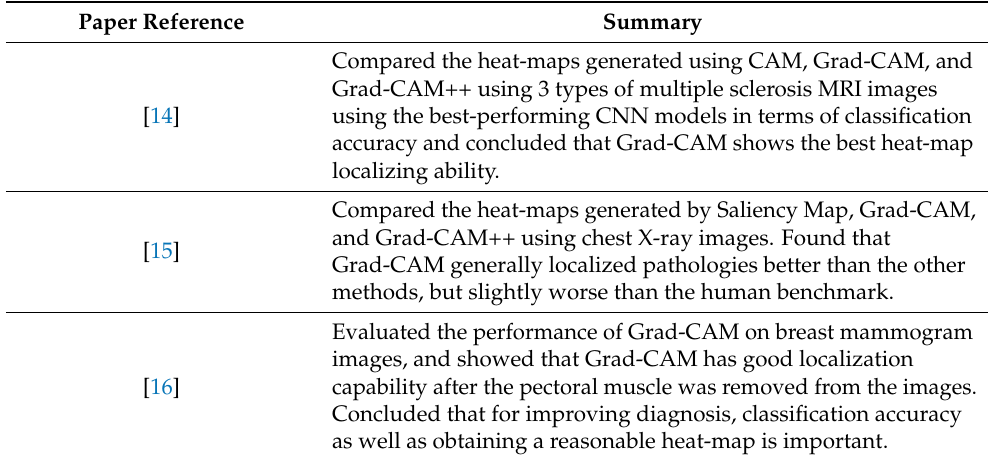
Table 1. Summary of related